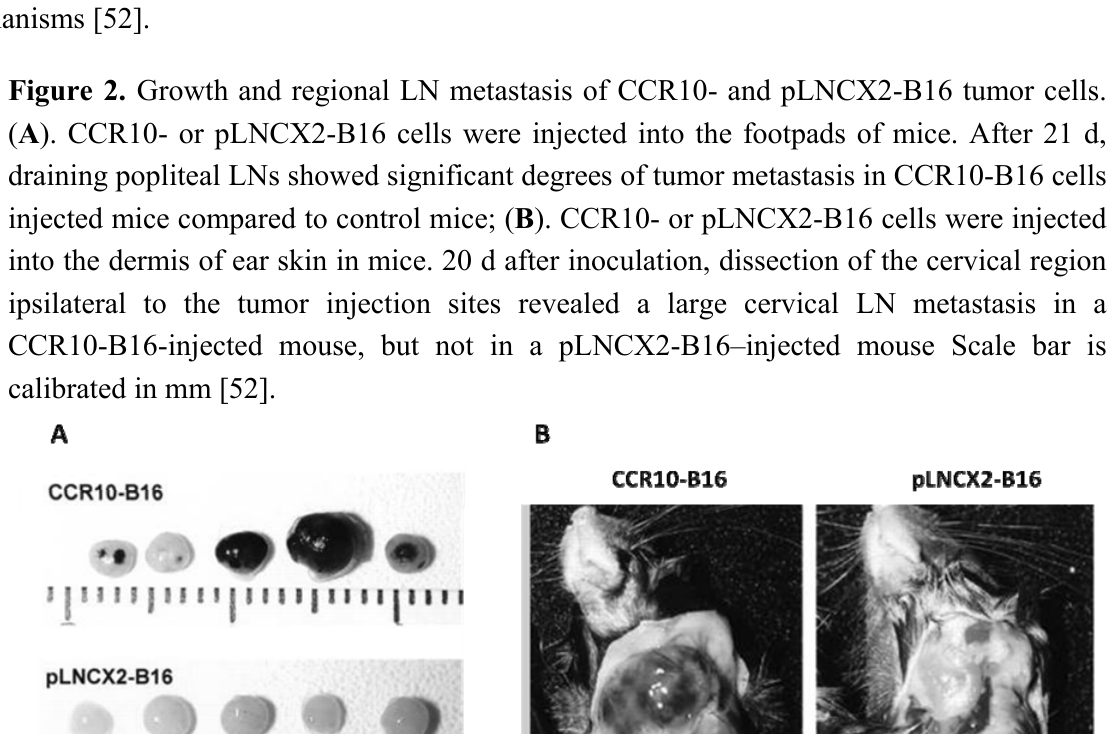
Figure 2. Growth and regional LN metastasis of CCR10- and pLNCX2-B16 tumor